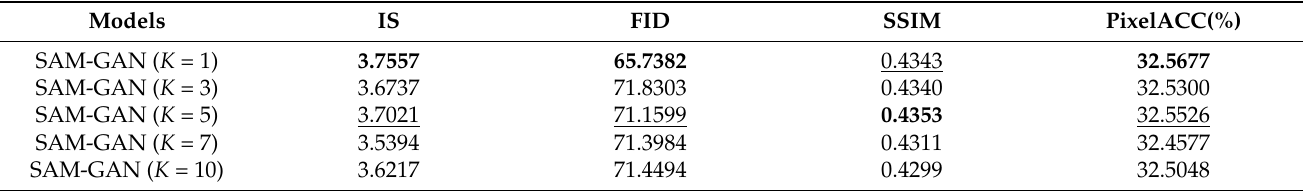
Table 4. Quantitative assessment scores of the SAM-GAN model for different K values where δ is taken as 5. (Bold: first in performance; underlined: second in